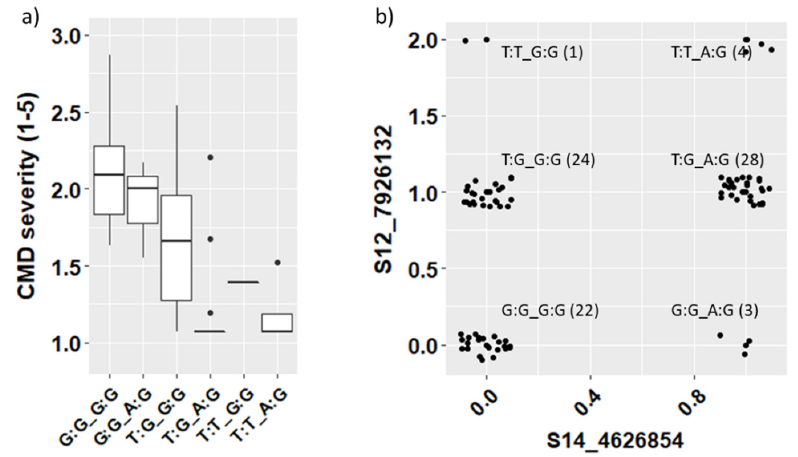
Figure 5. The combined effect and similarity of the markers S12_7926132 and S14_4626854 in CIAT102. ( a ) The CMD score of the clones grouped based on the two CMD markers. The x-axis showed the genotype combination. For example, T:G_G:G means the clones had T:G alleles of S12_7926132 and G:G alleles of S14_4626854. ( b ) The genotypic similarity between the two markers S12_7926132 and S14_4626854. The two markers matched well for the susceptible